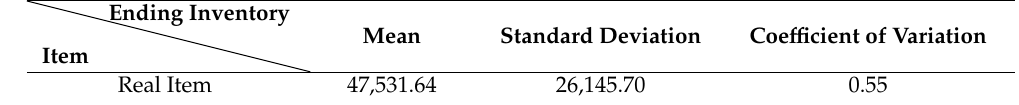
Table 1. Basic data for product